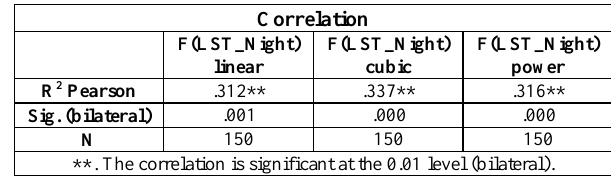
Table 4. Significance test of R Pearson